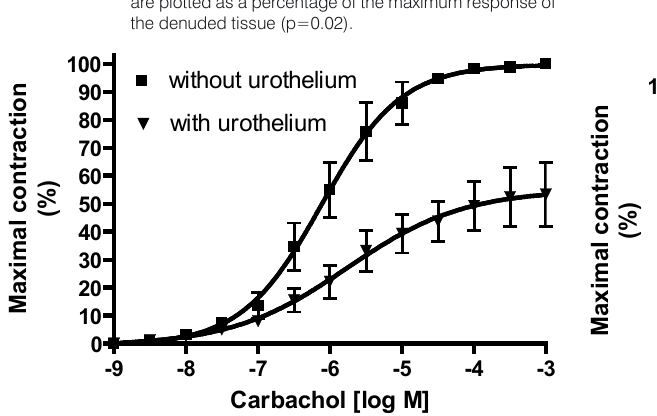
Figure 3. Responses to carbachol of detrusor strips with an intact urothelium or with the urothelium removed. Responses are plotted as a percentage of the maximum response of the denuded tissue (p=0.02).